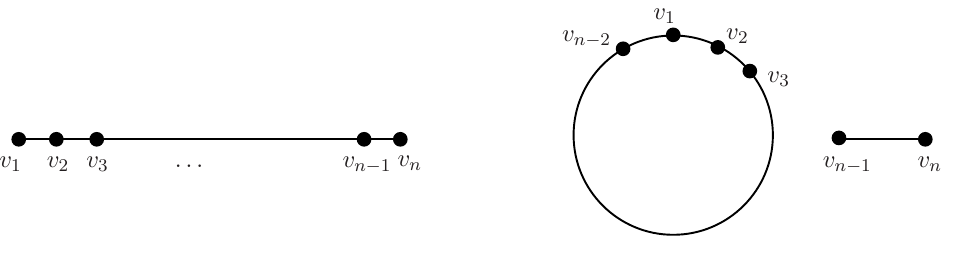
Figure 2: Some connected and disconnected almost regular graphs when m = n − 1